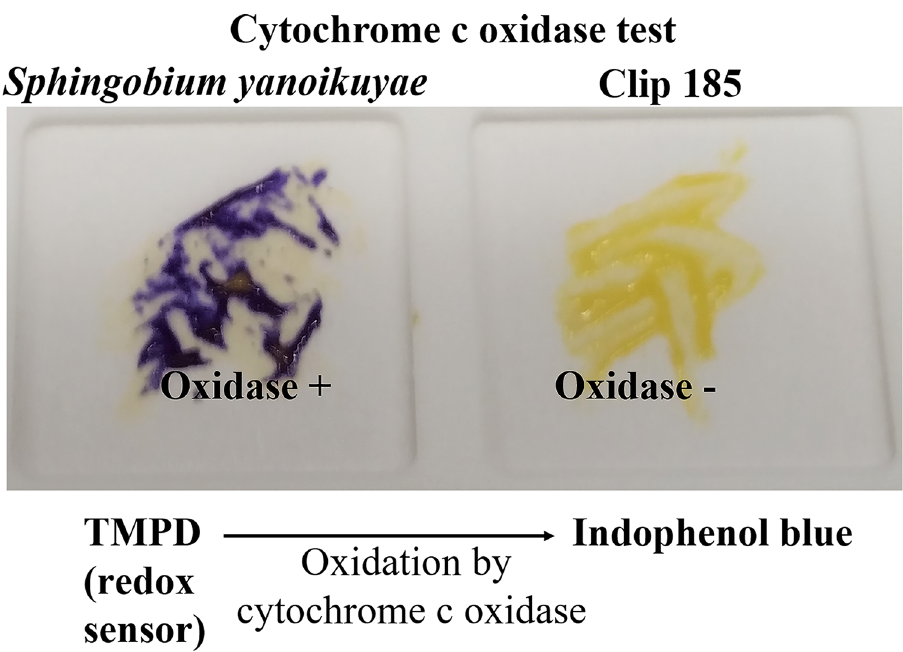
Figure 6. Clip185 is oxidase-negative. Cells of Sphingobium yanoikuyae (on the left) and Clip185 (on the right) streaked on a disposable slide containing a film coated with oxidase reagent tetramethyl-p-phenylenediamine dihydrochloride (TMPD). Image of the slide was taken after 10 seconds of the application of the cells on the (Figure 7B; Figure 7D) but it did not grow on TP + 1% lactose plate (Figure 7F). Fermentation of glucose and sucrose produced acids which decreased the pH in the TP medium. With the decrease in pH, phenol red ’ s light red color changed to a yellow color (Figure 7B; Figure 7D).